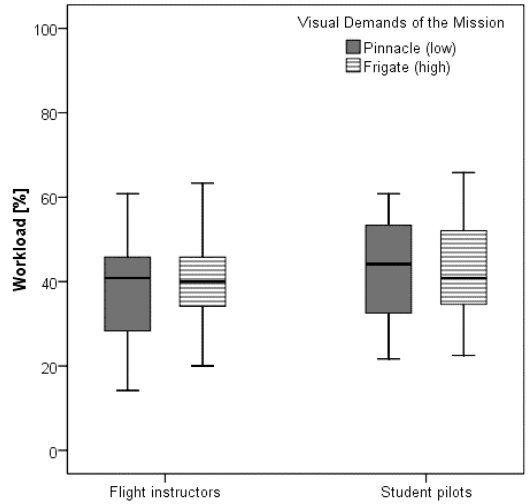
Figure 8. Boxplot for Workload (M for total sample dashed).